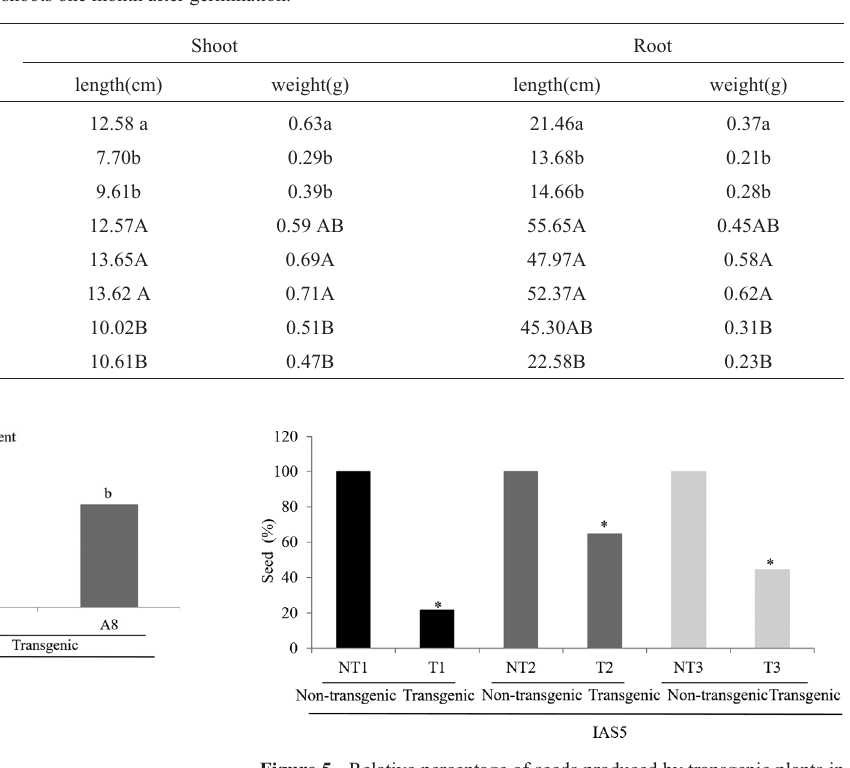
Figure 5 - Relative percentage of seeds produced by transgenic plants in three generations (T 1 , T 2 and T 3 ). The mean number of seeds produced by non-transgenic plant was considered 100%. Transgenic plants and non-transgenicplantsarefromcv.IAS5.*indicatesthatthemeanoftrans- genic seeds is significantly different from non-transgenic in each genera- tion ( t -test, p < 0.05).